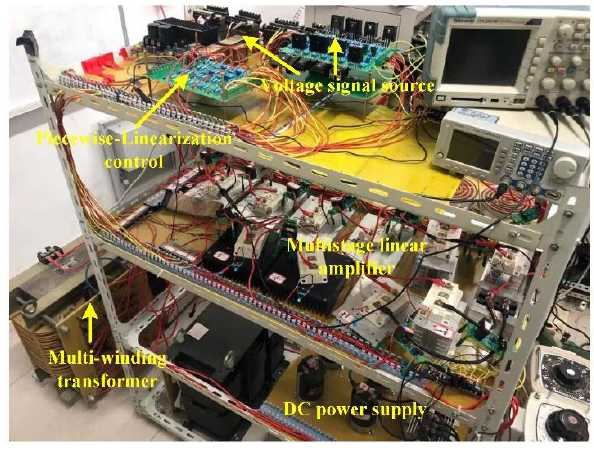
Figure 8. Experiment platform.